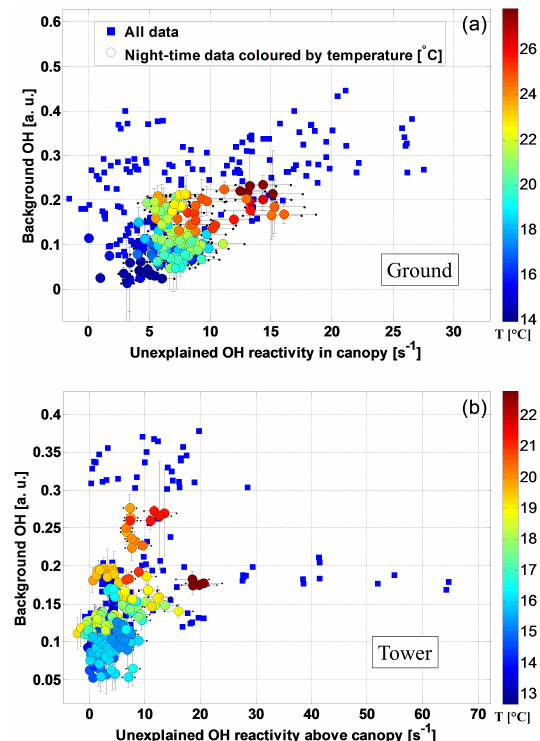
Figure 6. Background OH as a function of unexplained OH re- activity for ground and tower period measurements during the HUMPPA-COPEC 2010 campaign. Squares represent the daytime data; bullets represent night-time data and are coloured according to temperature (right